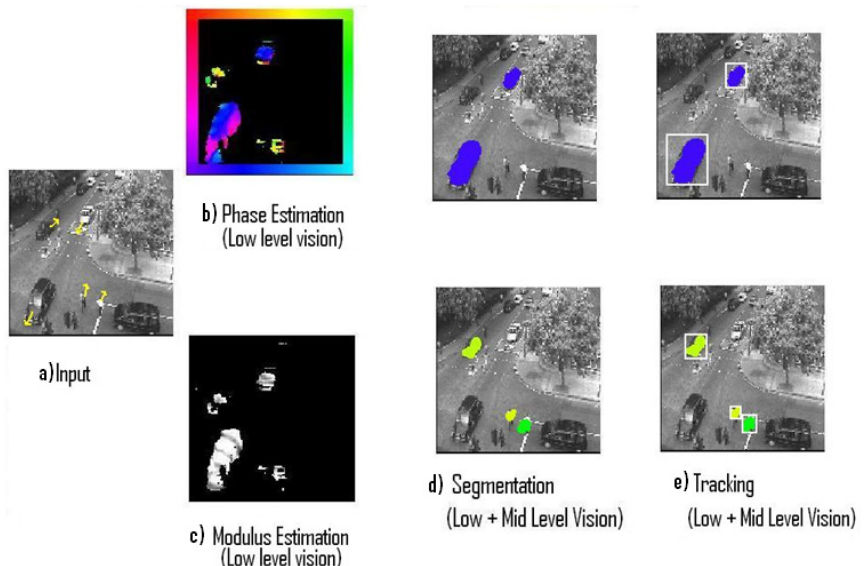
Figure 3. Results from Experiment